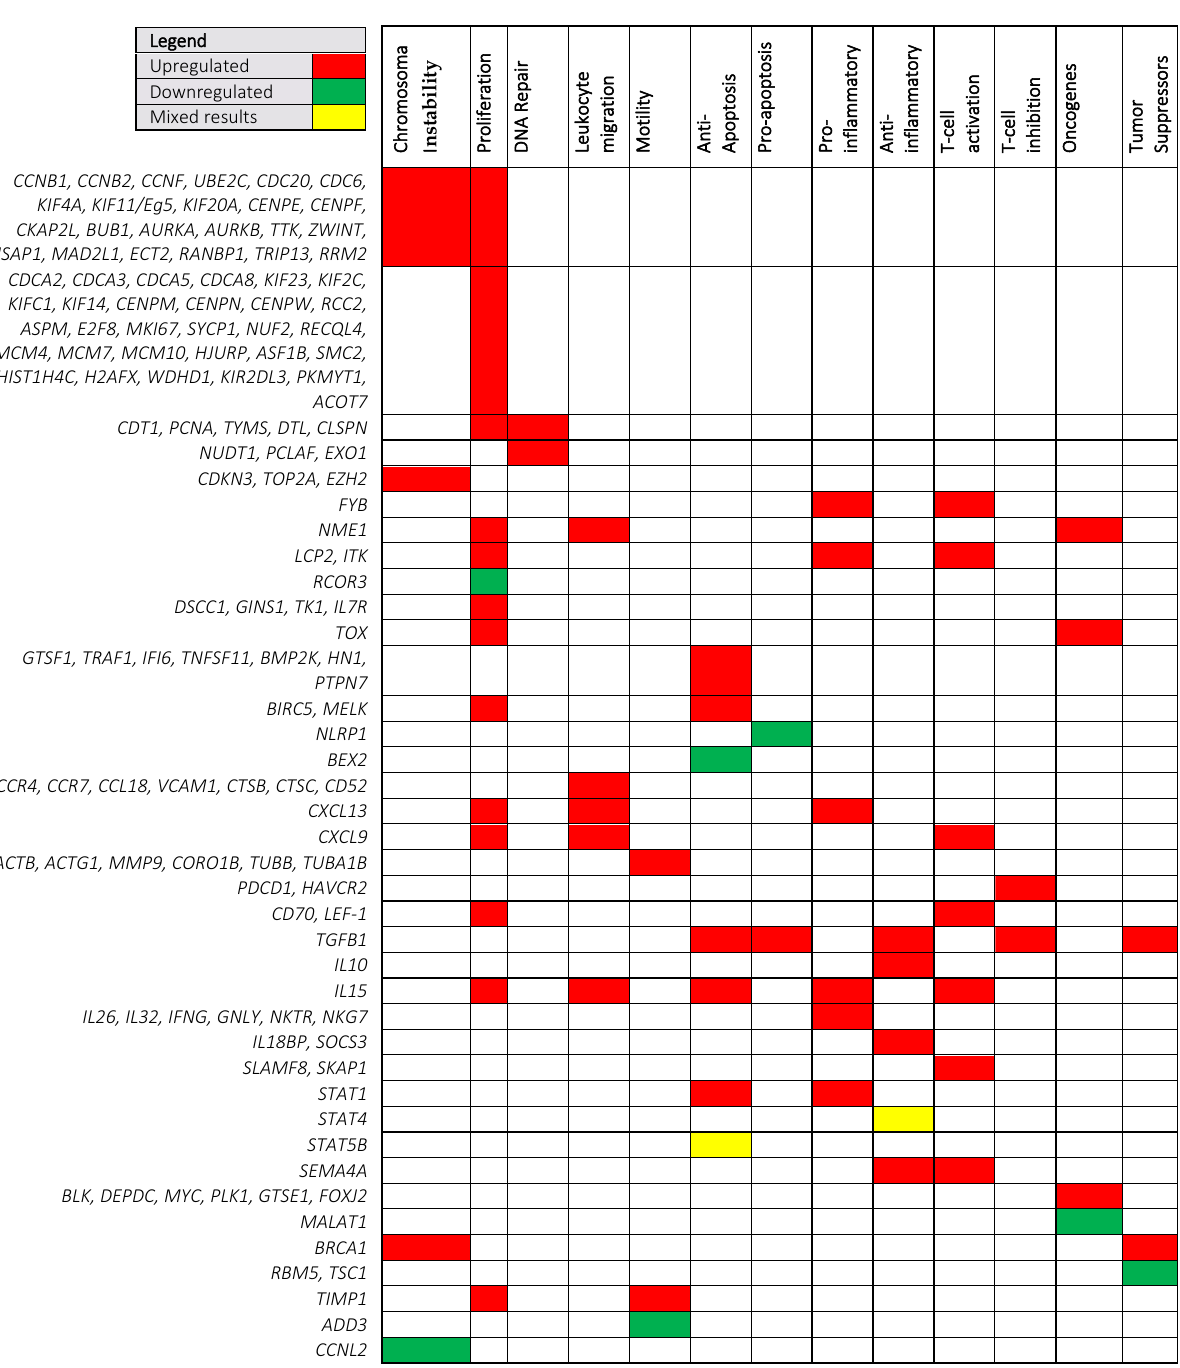
Figure 2. Differentially expressed genes in mycosis fungoides. The majority of the differentially expressed genes ( n = 118) were categorized according to their function in Chromosomal Instability, Proliferation, DNA Repair, Leukocyte migration, Motility, Anti-Apoptosis, Pro-apoptosis, Pro-inflammatory, Anti-inflammatory, T-cell activation, T-cell inhibition, Oncogenes, and Tumor Suppressors. Although the remaining genes ( n = 16) were differentially expressed, they could not be ascribed to an obvious function in MF: NPHP3, ACVRL1, FUCA1, SECISBP2, CSAD, ATP5J2/ATP5MF, GOLGA8A, SLCO2B1, TESC, TTYH3, CLK4, cTAGE1, EIF5A, MRPL12, SNRPD1 , and SCG2